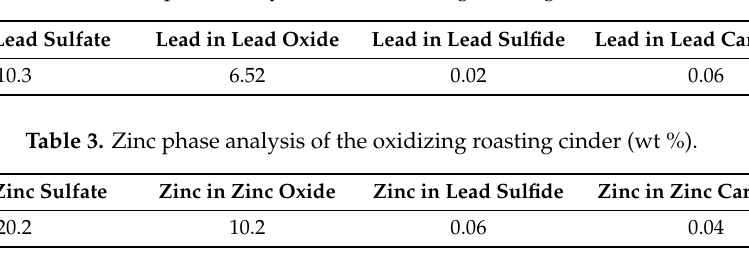
Table 4. Size fraction analysis of the oxidizing roasting cinder.